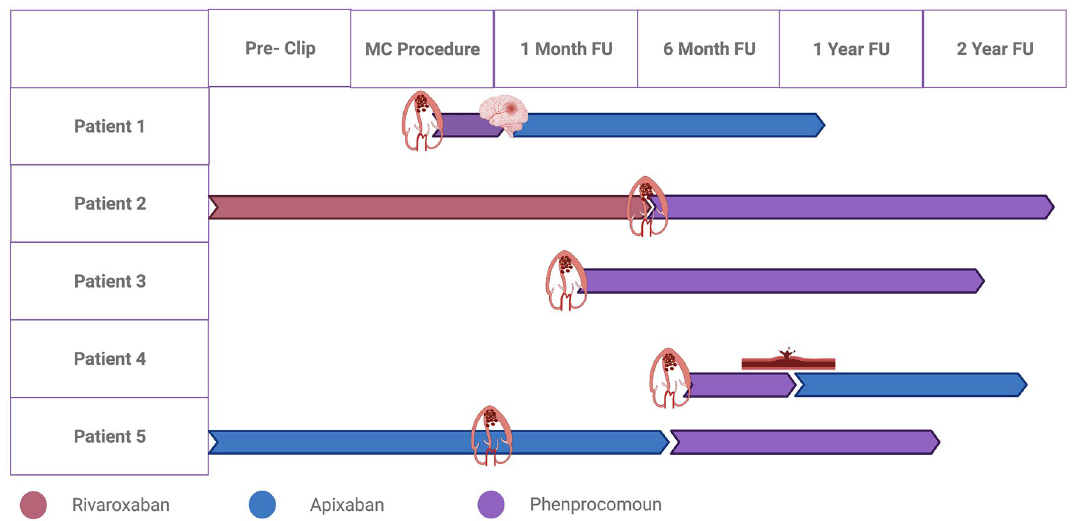
Figure 2. Gantt chart with time points of thrombus detection and prescribed anticoagulation